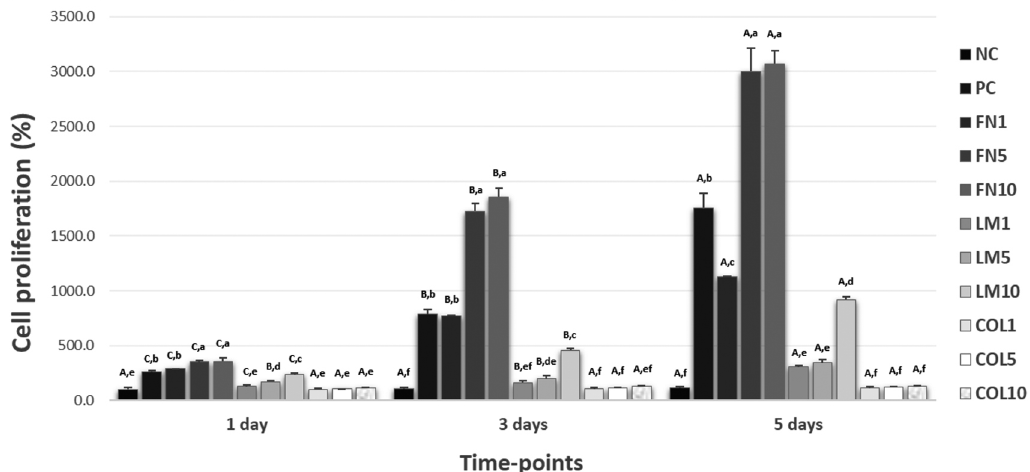
Figure 3- Mean and standard deviation of cell proliferation values (n=6; two-way ANOVA/Tukey tests; α =0.05). Different capital letters indicate a significant difference between the time-points for each group. Different lowercase letters demonstrate a significant difference between groups in each